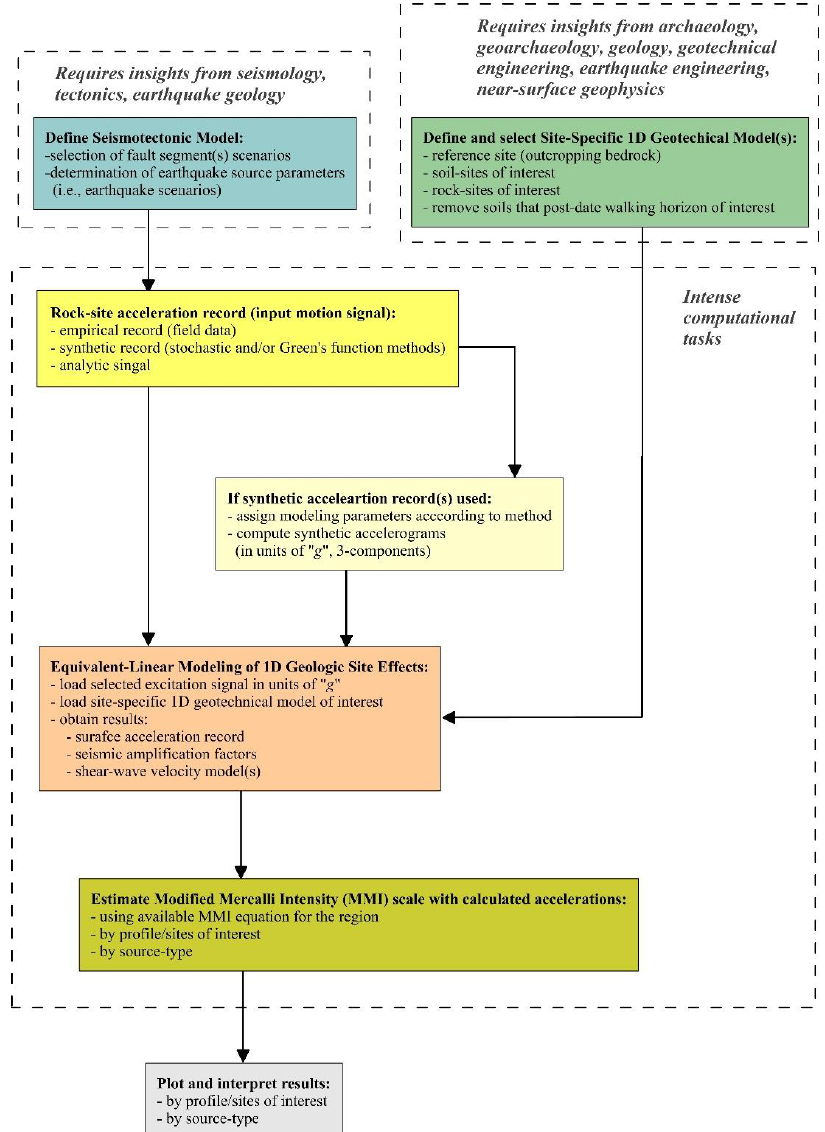
Figure 4. Schematized workflow of the proposed forward modeling of synthetic seismograms and 1D seismic site effects for an archaeoseismic project. The workflow honors an ancient earthquake’s archaeological, geological and seismotectonic context. Modified with permission from [39]. Copyright 2016, Hinojosa-Prieto, H.R.